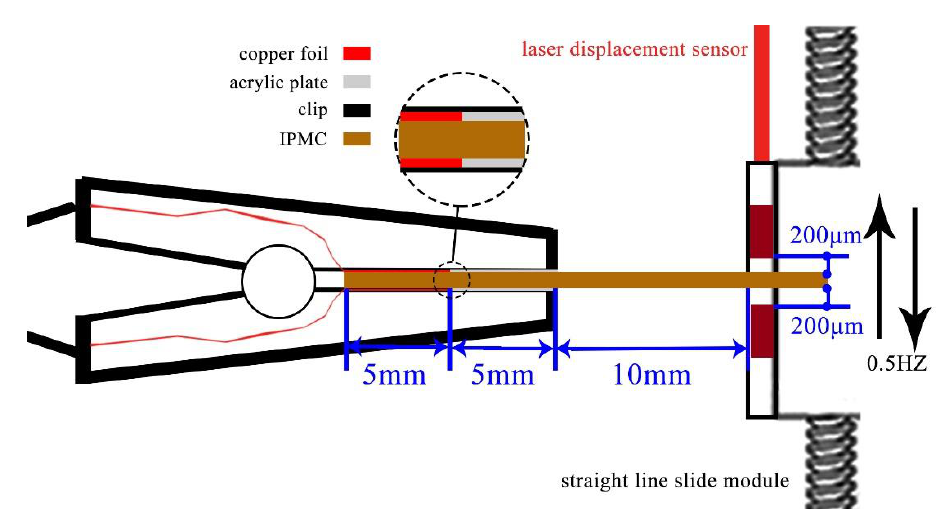
Figure 5. Sensing test platform for the IPMC sample.